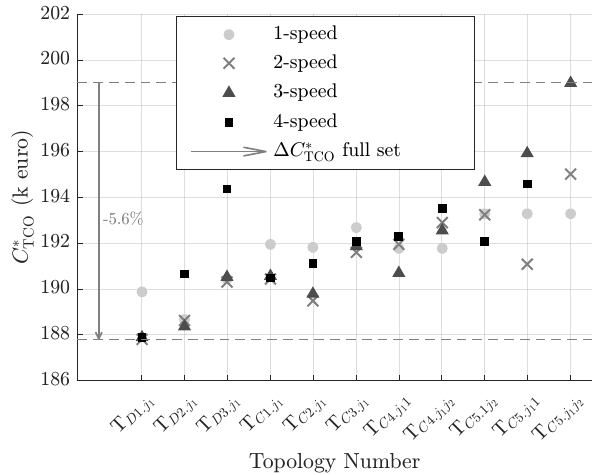
Figure 6. Optimal total-cost-of-ownership, C ∗ , for each configuration shown in Figure 2. TCO The different markers indicate the gearbox type present in the optimized topology. The dark gray arrow indicates the improvement from the powertrain configuration with the highest to the one with the lowest